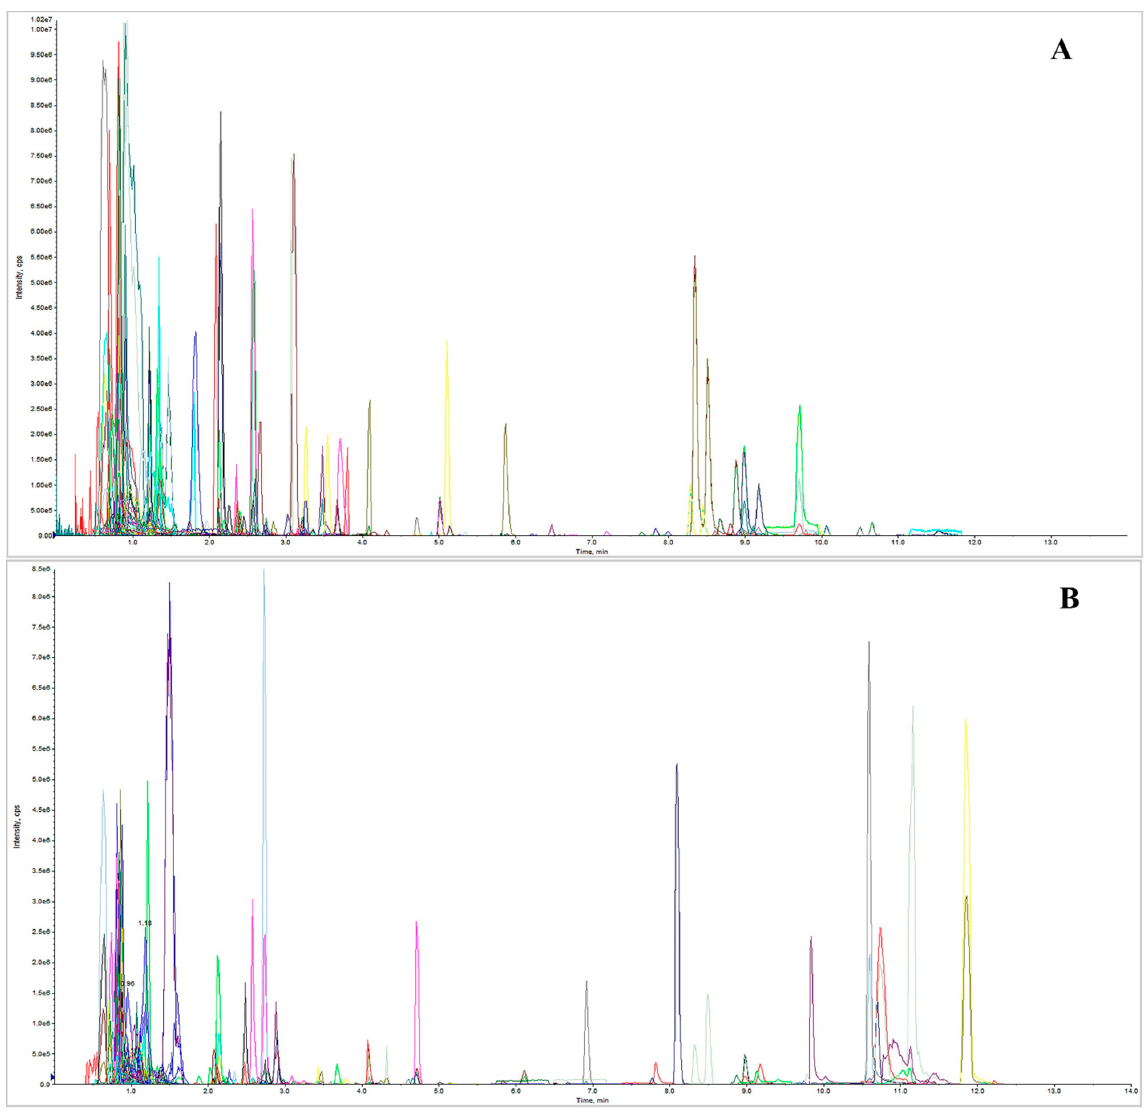
Figure 8. MRM detection of multimodal maps of maize seed embryos in the positive ( A ) and nega- tive ( B ) ion mode. Notes: The abscissa is the retention time (RT) of metabolite detection, and the ordinate is the ion current intensity of ion detection (the intensity unit is CPS, count per second). Each mass spectrum peak with different colors represents a metabolite detected.